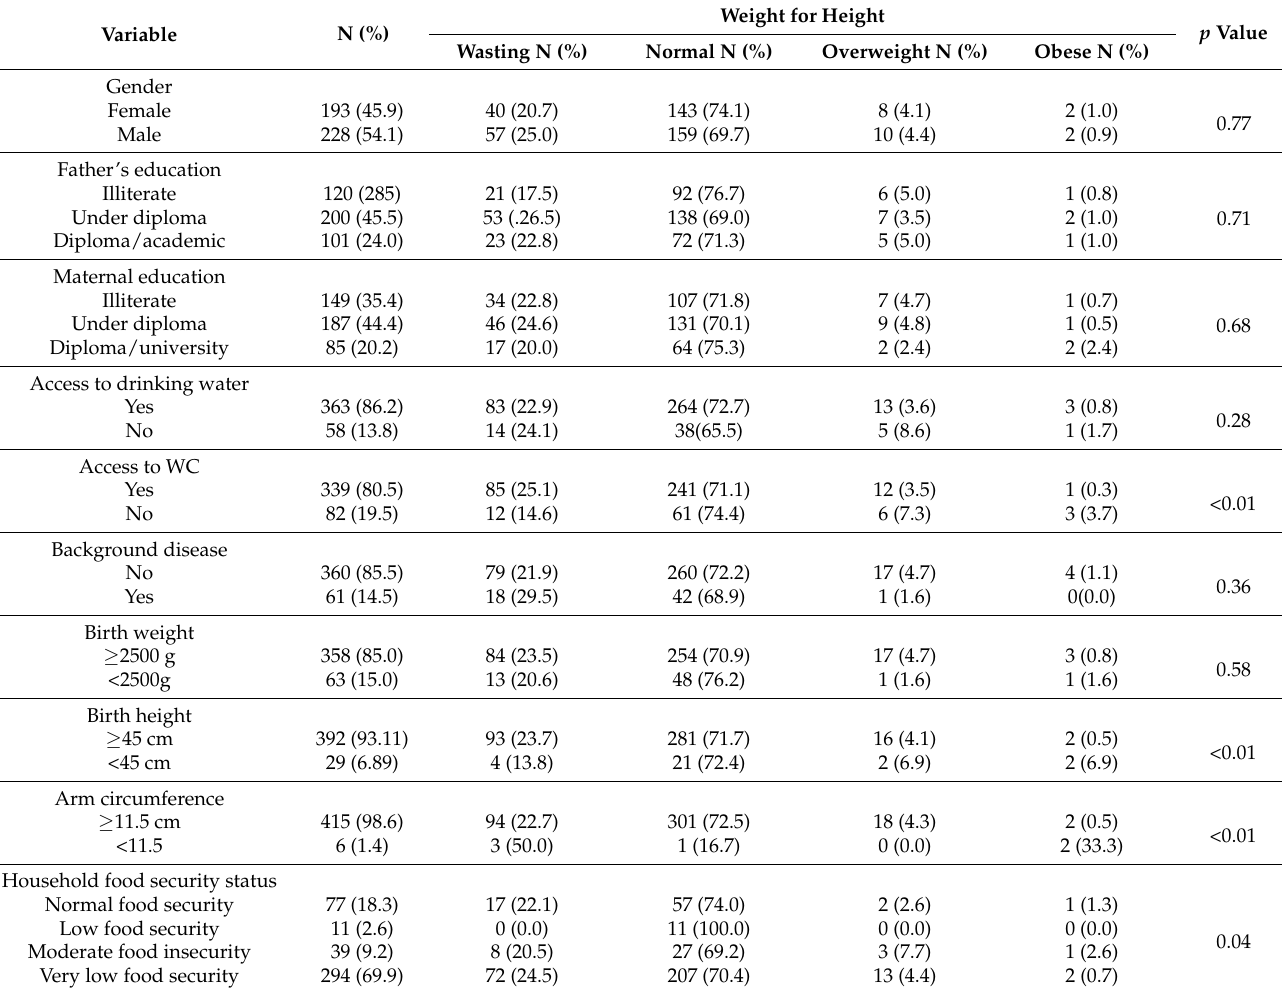
Table 3. The participants’ sociodemographic characteristics by weight for height.